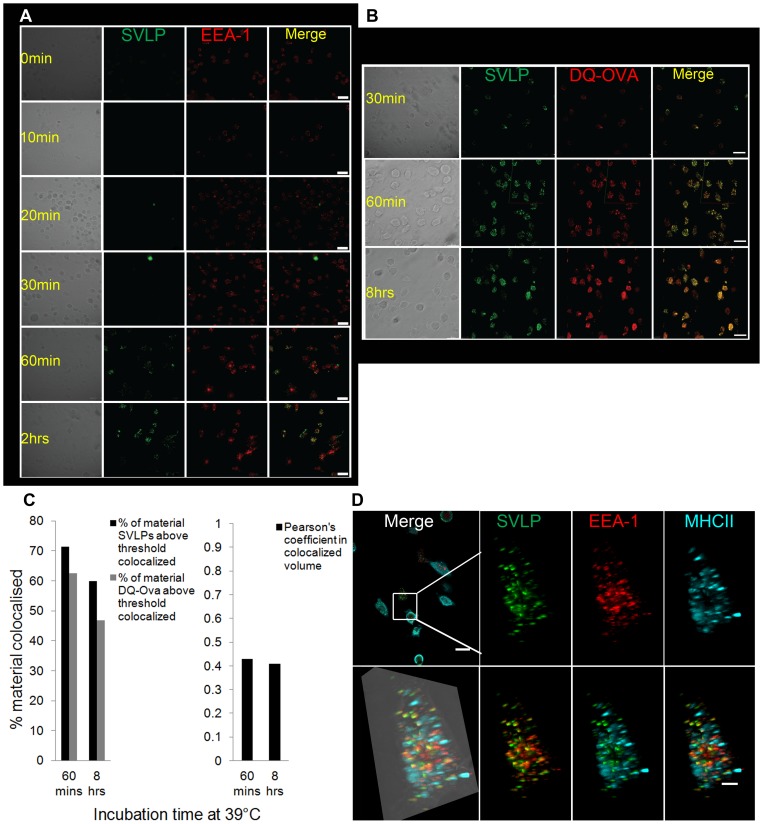
SVLP associating with early endosomes, MHCII and DQ-Ova.(A) Application of quenched SVLP signal to identify endosomal enzyme activity leading to de-quenching of the signal. DC were incubated with 2.5 µg/ml quenched SVLP (green) for different incubation times at 39°C. Samples were fixed, permeabilised and labelled with antibody targeting EEA-1 (red). Acquisition of the images was by confocal microscopy, followed by analysis and merging using IMARIS. Scale bars: 30 µm. (B) Cells were treated as for (A), but also with DQ- Ovalbumin. Acquisition of the images was by confocal microscopy, followed by analysis and merging using IMARIS. Scale bar: 20 µm. (C) Algorithmic co-localisation analysis of SVLP and DQ-Ova performed using IMARIS. (D) Cells were treated as for (A), but stained also for MHCII molecules (blue). Acquisition of the images was by confocal microscopy; high-resolution stacks were prepared using IMARIS. Scale bars: 20 µm (top left), 5 µm (zooms).